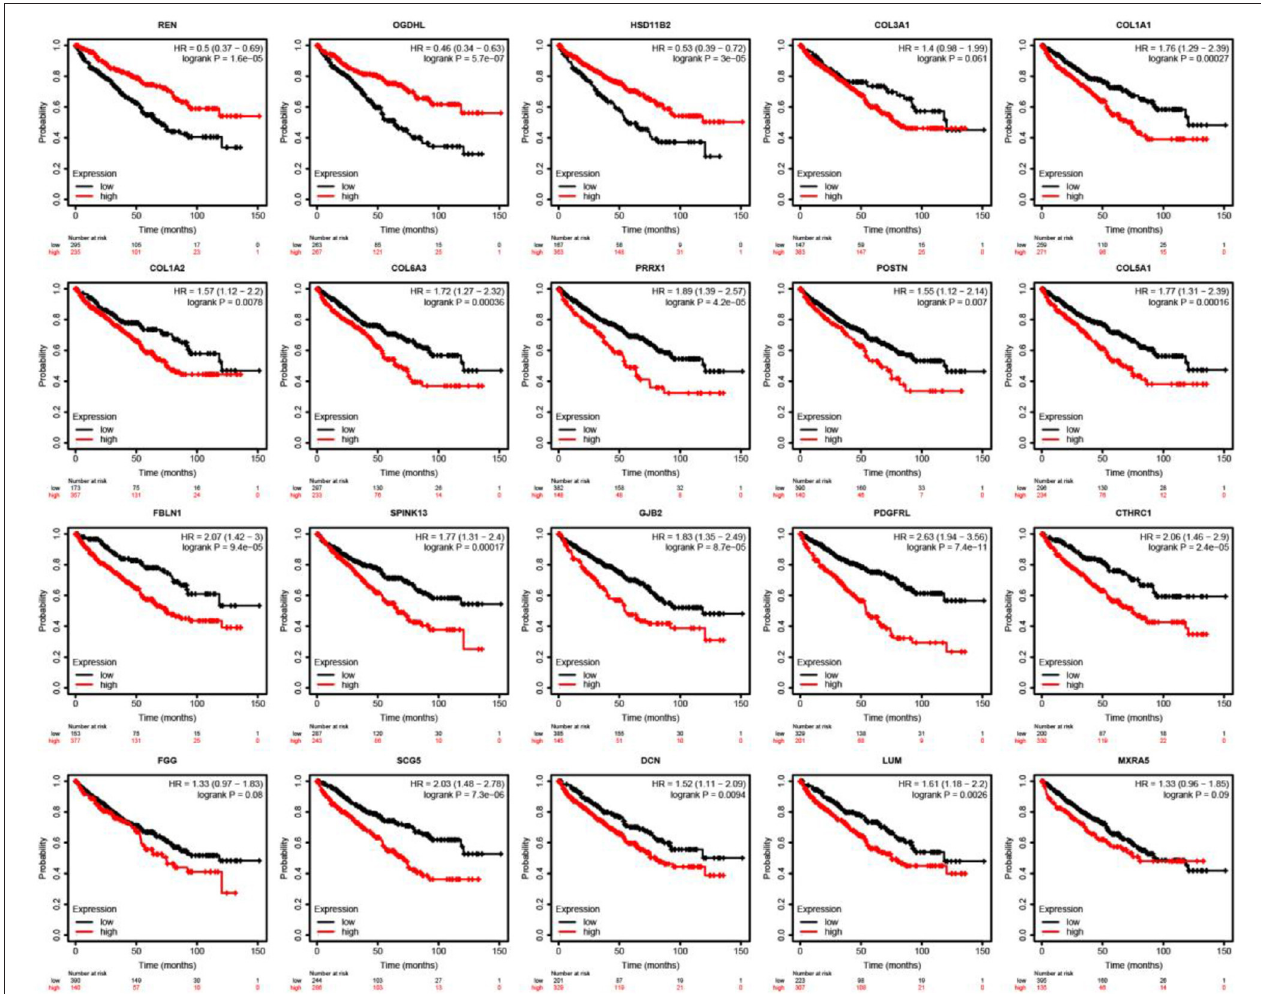
FIGURE 8 | Outcomes associated with mutation and immune infiltrates were illustrated in patients with ccRCC. Kaplan-Meier survival curves with the log-rank test and hazard ratio (HR) for overall survival are